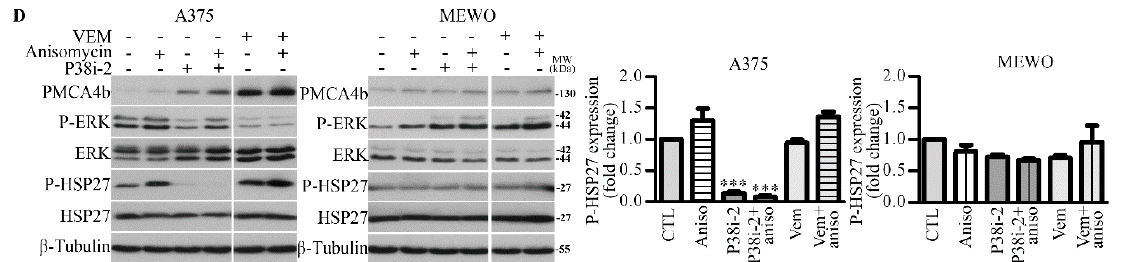
Figure 1. In BRAF mutant melanoma cells inhibition of p38 MAPK activity resulted in increased PMCA4b protein level while inhibition of the JNK and NF-kB pathways had no effect. ( A ) BRAF mutant (A375) and BRAF wild type cells (MEWO) were treated with inhibitors for NF-kB (BAY11-7082), JNK (SP600125), p38i-1 (SB203580) and p38i-2 (SB202190) at 10 µM concentrations for 48 h. 0.5 µM BRAF inhibitor (vemurafenib) was used as a positive control for PMCA4b protein expression. DMSO treatment was included as a vehicle control. ( B ) A375, SK-MEL-28 and MEWO cells were treated with increasing concentrations of the p38i-2 inhibitor for 48 h. In A375 and MEWO cells a combination of vemurafenib (0.5 µM) and p38i-2 inhibitor (10 µM) was tested after 48 h treatment by Western blotting. ( A , B ) β -tubulin was used as a loading control. Bars represent means ± SE from three independent experiments. ( C ) A375, SK-MEL-28 and MEWO cells were treated with p38i-1 SB203580 and p38i-2 inhibitor SB202190 at increasing doses for 48 h. Total mRNA was extracted and the level of PMCA4b mRNA was analyzed using qPCR. Data represent means ± SE from three independent experiments. ( D ) A375 and MEWO cells were treated with 0.5 µ M vemurafenib, 10 µ M p38i-2 SB202190, 2.6 µ g / mL anisomycin (positive activator of p38) alone or in combination with 10 µ M SB202190 for 48 h. Protein expression from total cell lysates was analyzed by Western. β -tubulin was used as a loading control. Bars represent means ± SE from three (A375) and two (MEWO) independent